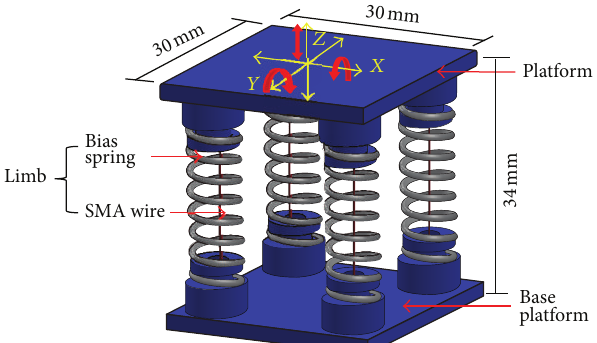
Figure 2: Stewart platform design.